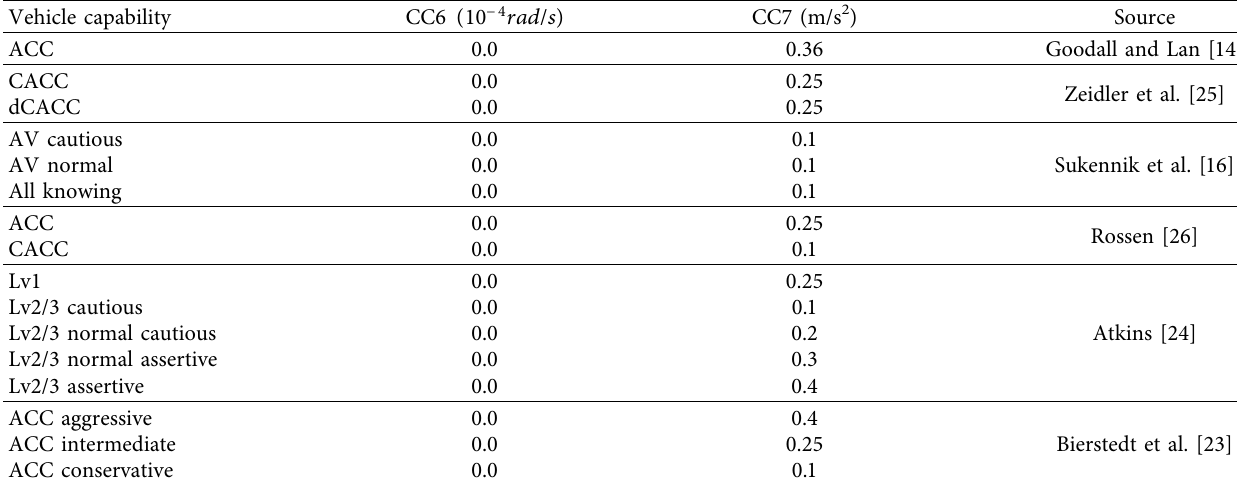
Table 4: Speed dependency of oscillation (CC6) and oscillation of acceleration (CC7) values for the Wiedemann 99 model. Vehicle capability